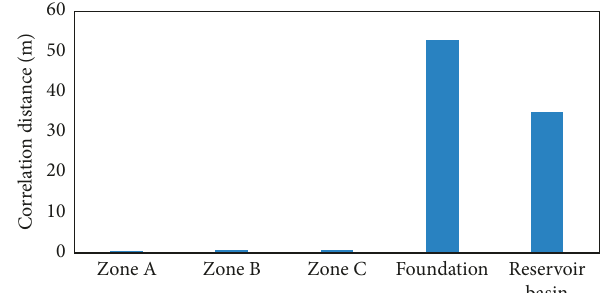
Figure 13: Standard deviation of deformation modulus of different zones.